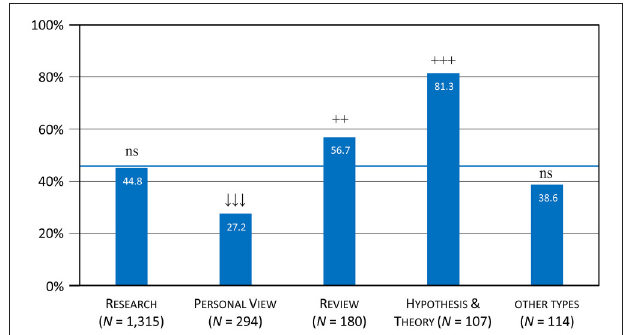
FIGURE 3 | Proportion of article types with theory-related terms ( Table 4B , all six terms). The blue line represents the average proportion of 44.9% based on the total of 2,046